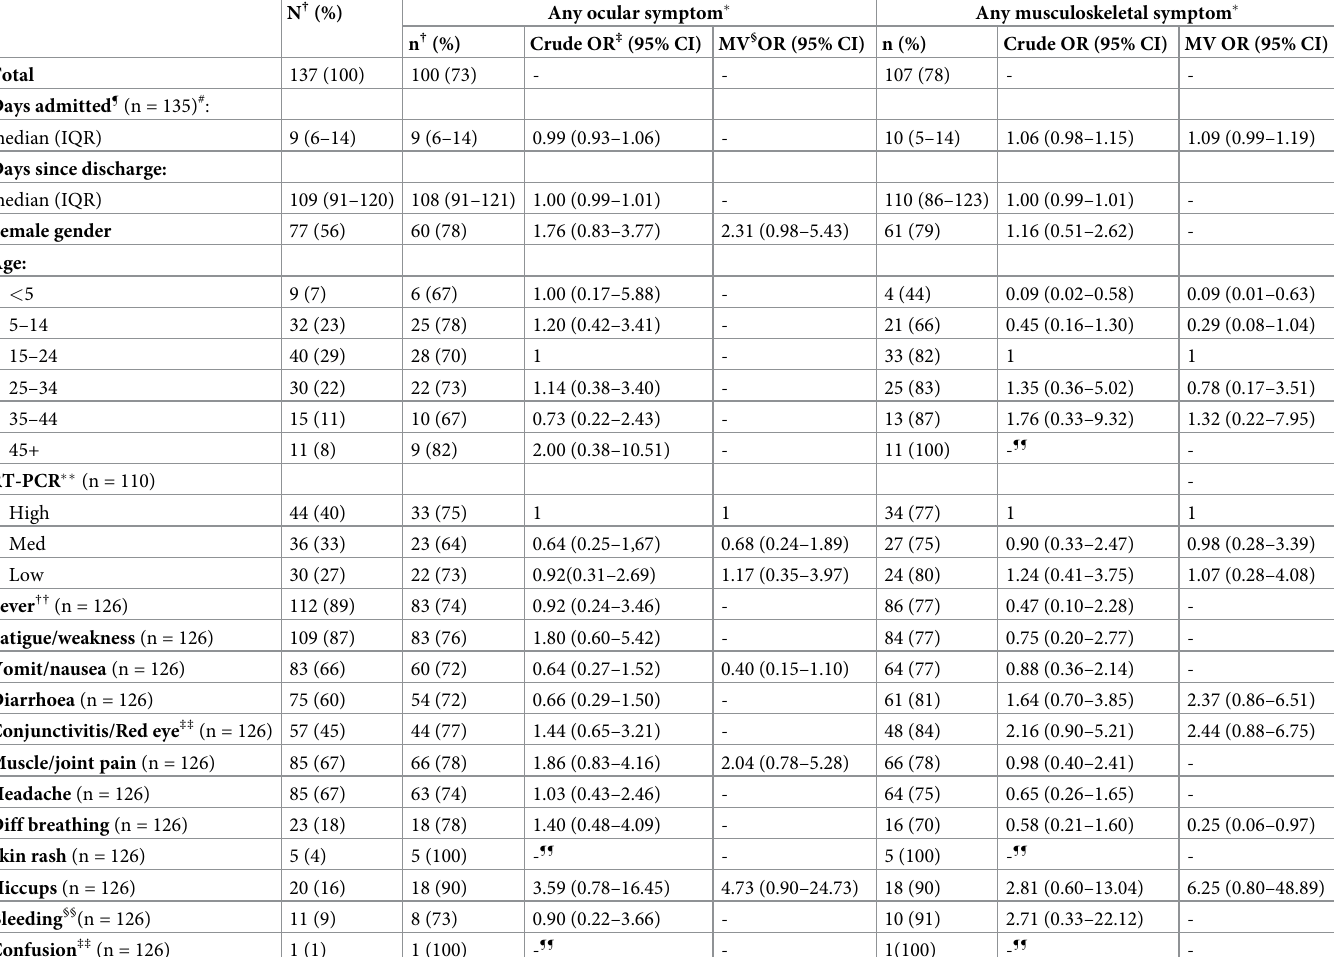
Table 3. EVD acute-phase predictors for ocular or musculoskeletal post-viral symptoms amongst people admitted to the Kerry Town ETC who survived and attended at least 1 Kerry Town EVD survivor